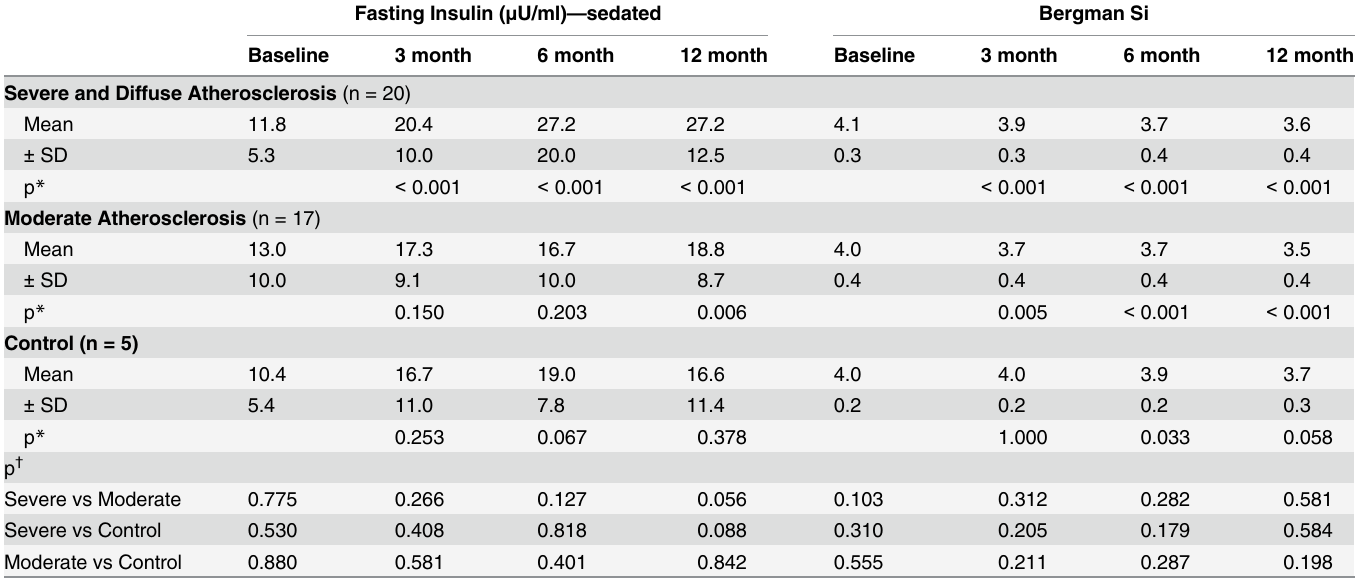
Table 4. Fasting Insulin Levels and Bergman Si Values. Fasting Insulin ( μ U/ml) —